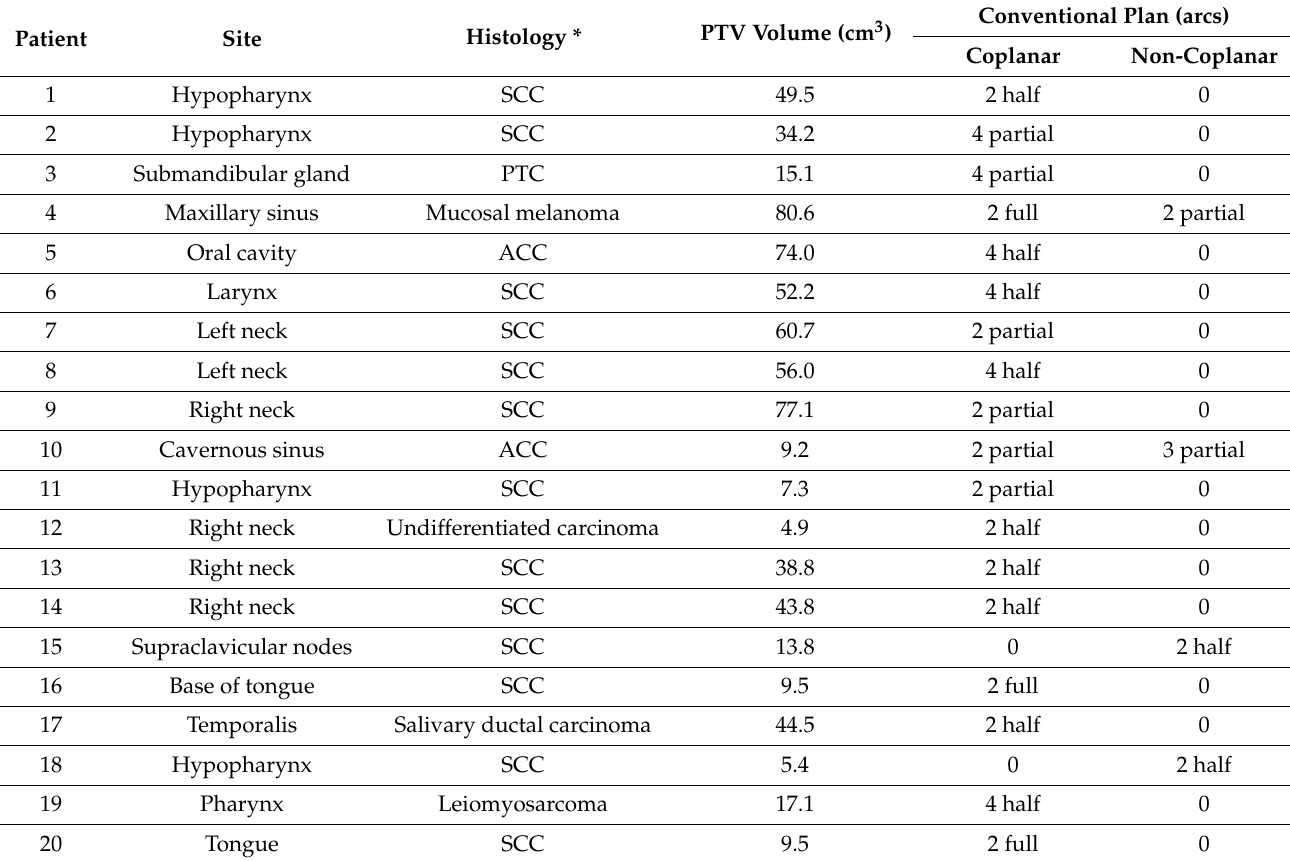
Table 1. Target and conventional plan characteristics for the 20 rHNC patients in the